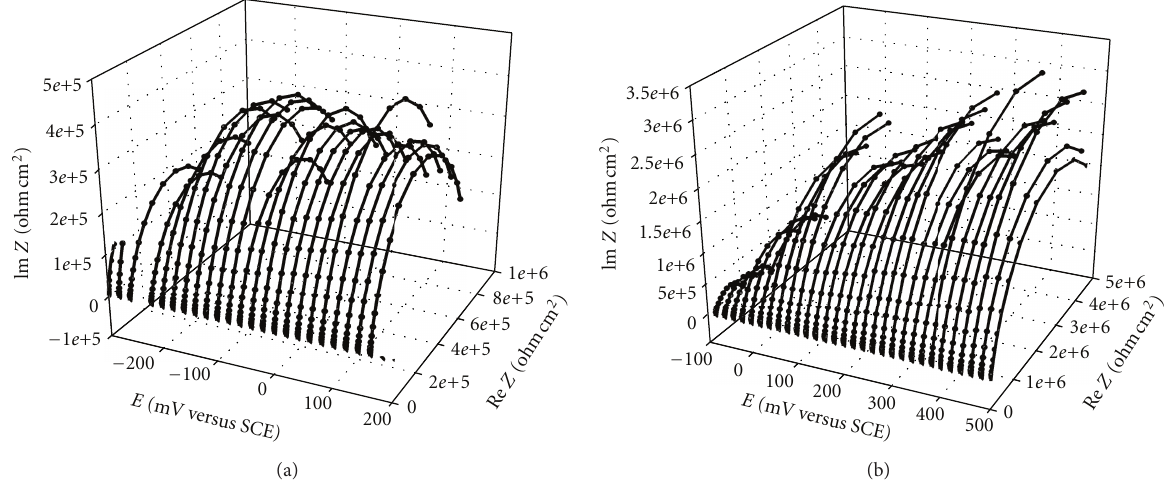
F 3: e impedance versus potential diagram of (a) NiTi and (b) NiTiNb alloys.